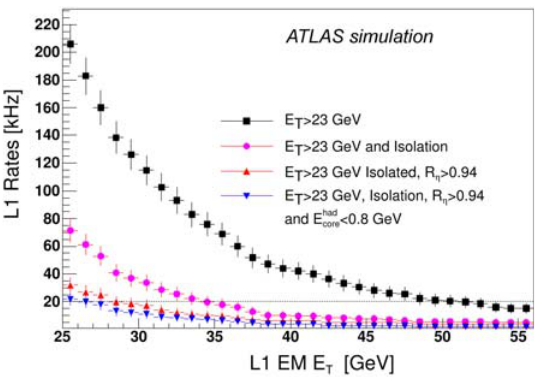
Figure 2. Level-1 trigger rate estimated using simulation as a function of E T threshold at 3 × 10 34 cm − 2 s − 1 with di ff erent selec- tion conditions[4].